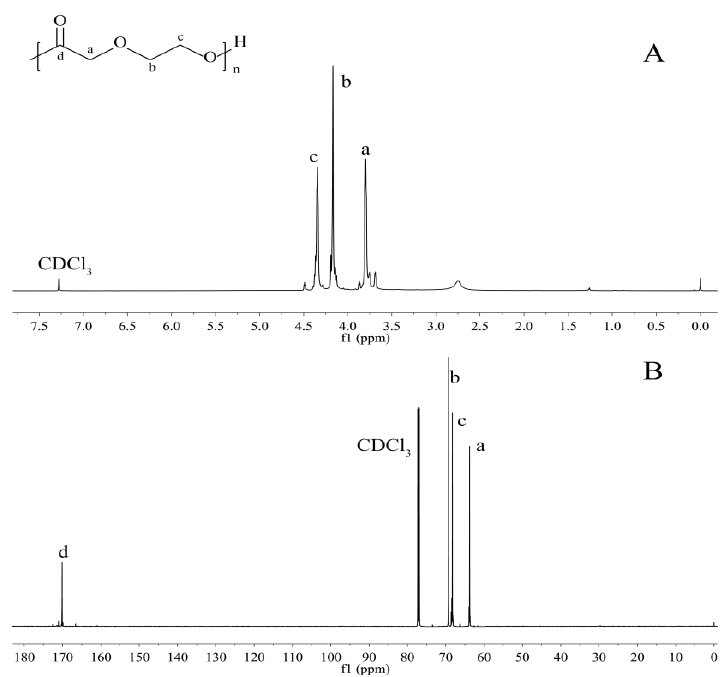
Scheme 2. The proposed mechanisms for the ring-opening graft polymerization of PDO with xylan catalyzed by DBU ( A ) and the homopolymerization of PPDO catalyzed by DBU ( B ) or [Bmim]Cl ( C ).